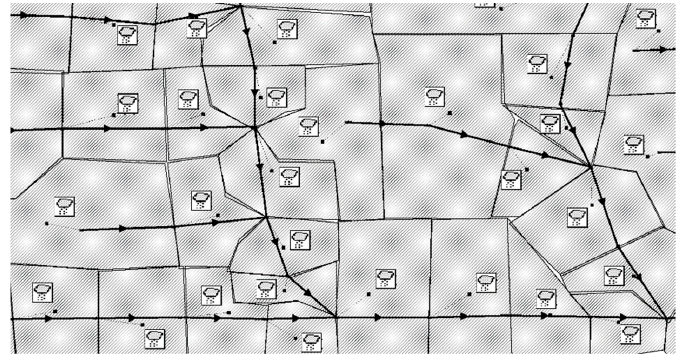
Figure 3. Partial sub-catchments with individual RAIN module.